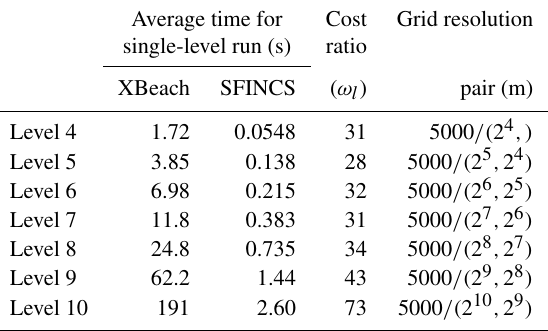
Table 1. Summary of average time taken to run SFINCS and XBeach at each level for the non-breaking wave test case. As can be seen from Eqs. (B4) and (3), at every level (apart from the coarsest level) a pair of simulations at two different resolutions is required. These resolutions are shown in the “grid resolution pair” column, and we recall that the same resolutions are used in each model. Average time